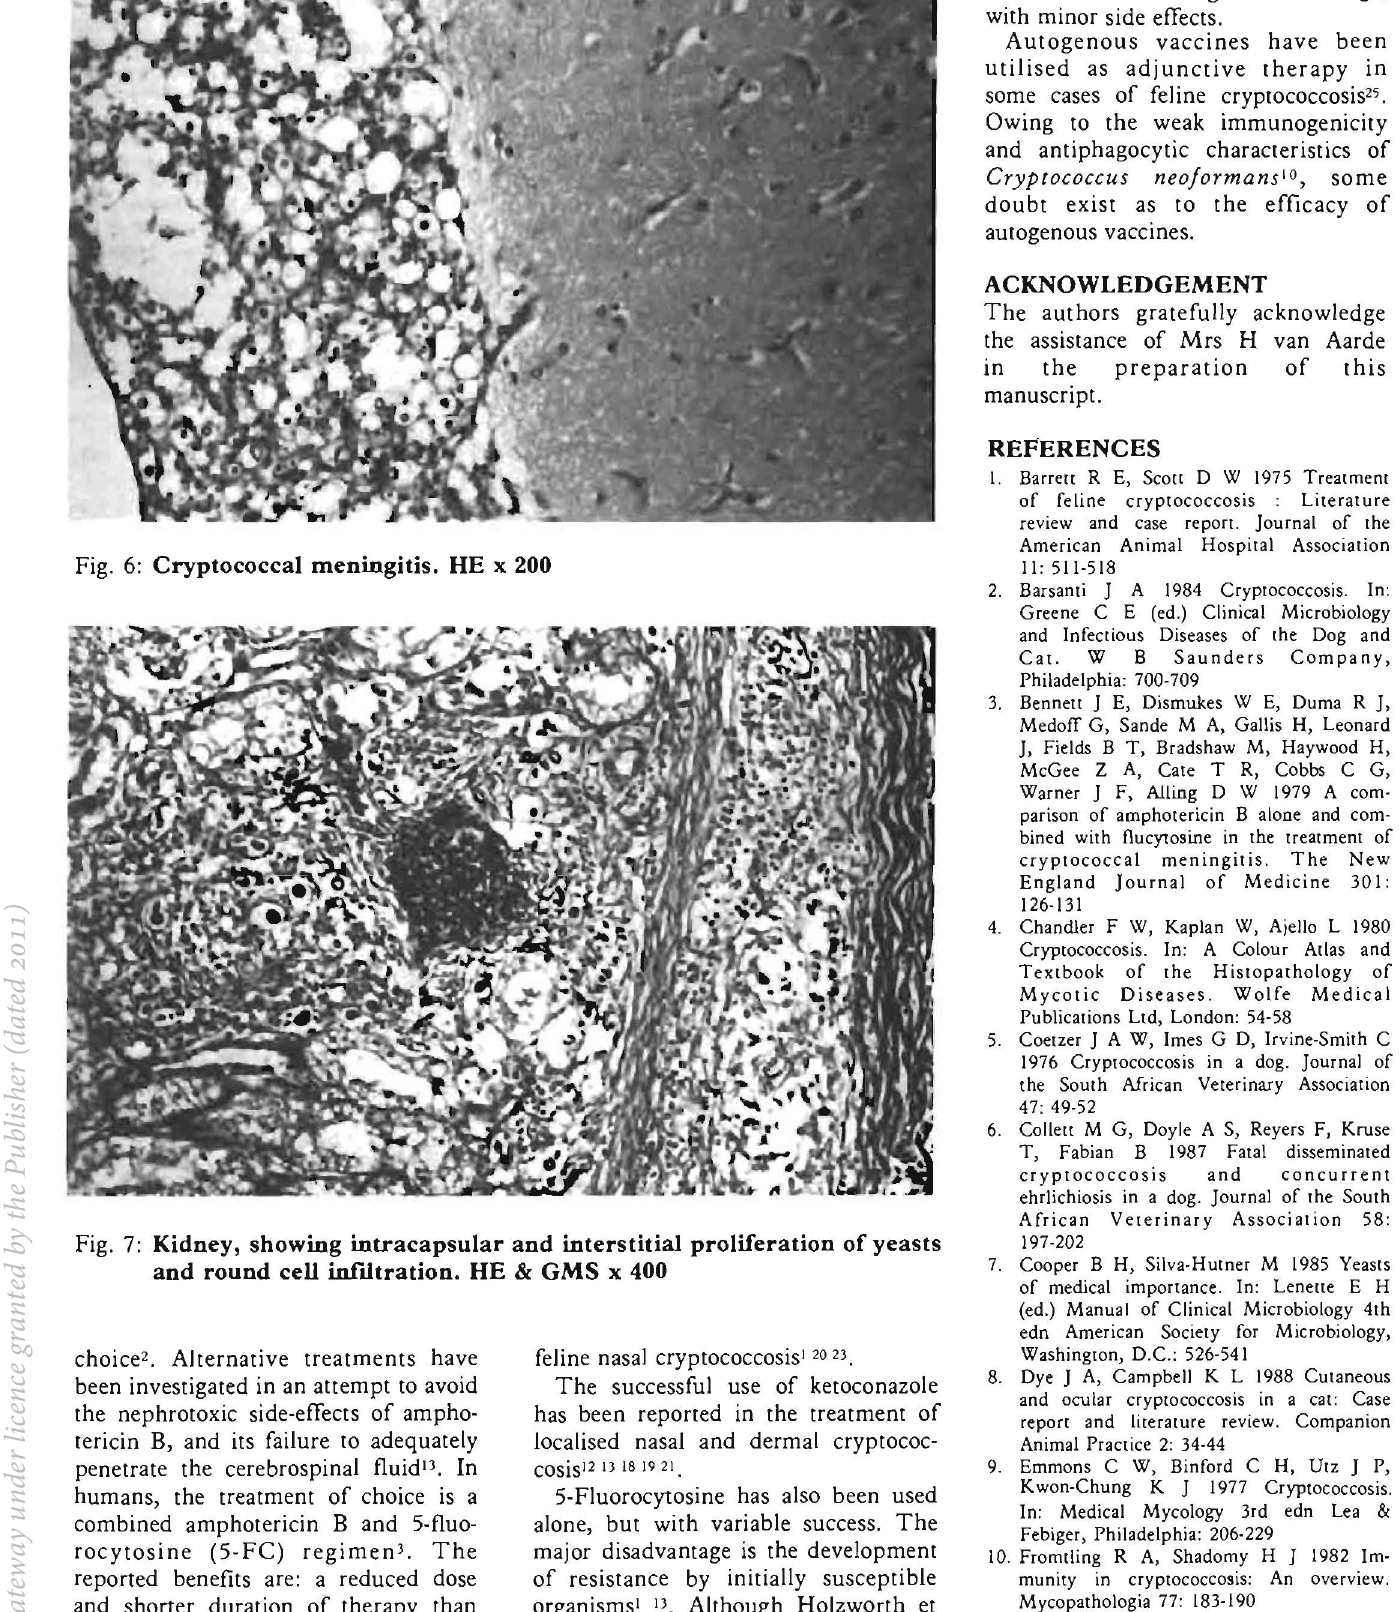
Fig. 6: Cryptococcal meningitis. HE x 200